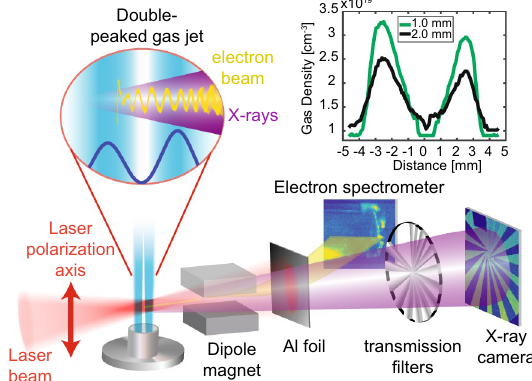
Figure 1. Schematic of experimental setup. A high-power laser (red) is focused into a double-peaked “M” shaped gas jet (blue). The laser evolution during the first density peak leads to off-axis electron injection during the following density downramp. Subsequent large-amplitude betatron oscillations (yellow) cause emission of intense X-ray radiation (purple). The laser pulse is filtered out by a thin Al foil. The electron bunch is deflected and characterized using a dipole magnet spectrometer. The X-rays are measured using an absorption-filter based spectrometer. The inset shows gas density measurements for a distance of y = 1 mm (green) and y = 2